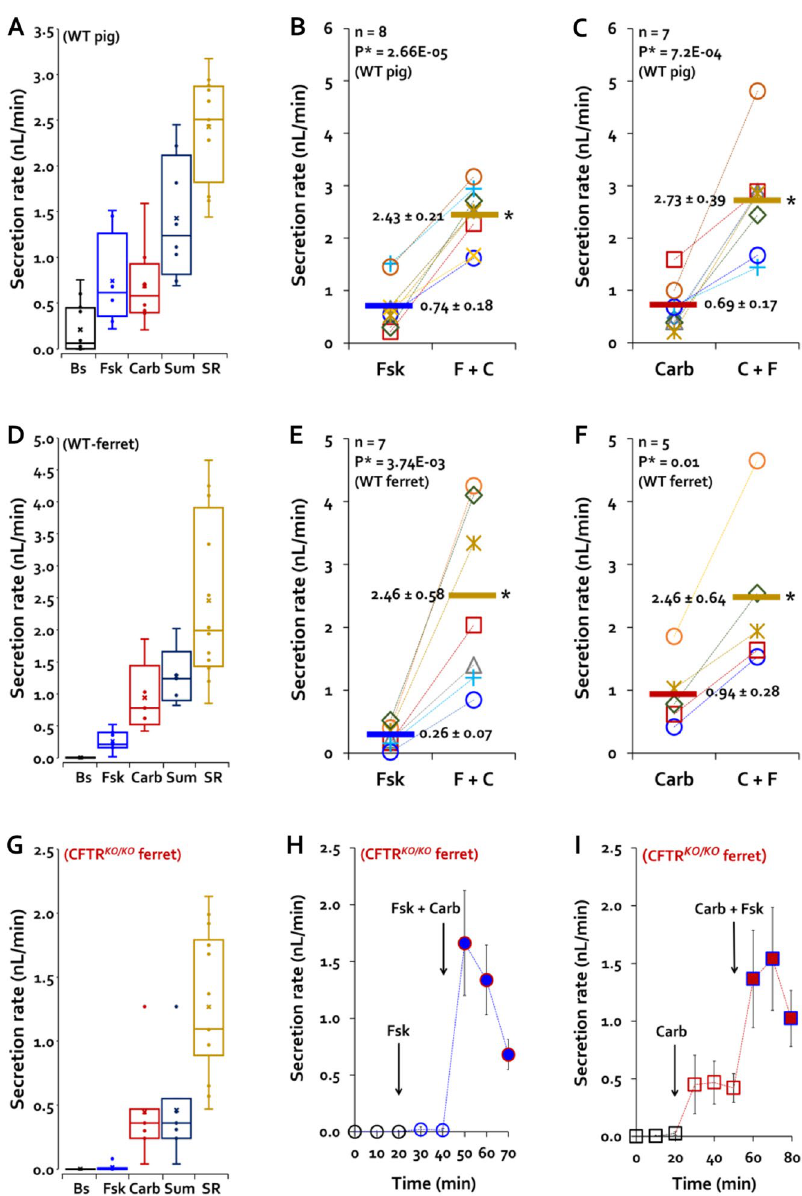
Figure 3. Combined agonists increase gland mucus secretion synergistically. Average secretion rates are summarized as box and whisker plots for 15 WT pigs ( A ), 12 WT ferrets ( D ) and 2 CF ferrets ( G ) using the same labeling as in Fig. 1. Each agonist increased secretion over baseline values, and rates to the combined agonists (SR) were significantly larger than the arithmetical sum (Sum) of their individual responses. ( B ) Average secretion rates for individual WT pigs to 10 µM forskolin alone and combined with 0.3 µM carbachol (60 glands, 8 pigs). ( C ) As in B but with carbachol alone and combined with forskolin (60–61 glands, 7 pigs). ( E,F ) WT adult ferret data with same conditions as in pigs (26–29 glands, 7 ferrets). ( H,I ) CF ferret data produced with same conditions as pigs and WT ferrets. A single ferret was run in each condition and secretion rates were measured in 7–14 glands. Time courses of average responses are plotted at 10 min